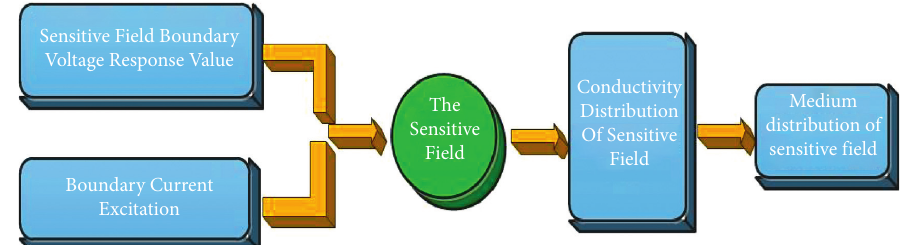
Figure 4: ERT inverse problem-solving process